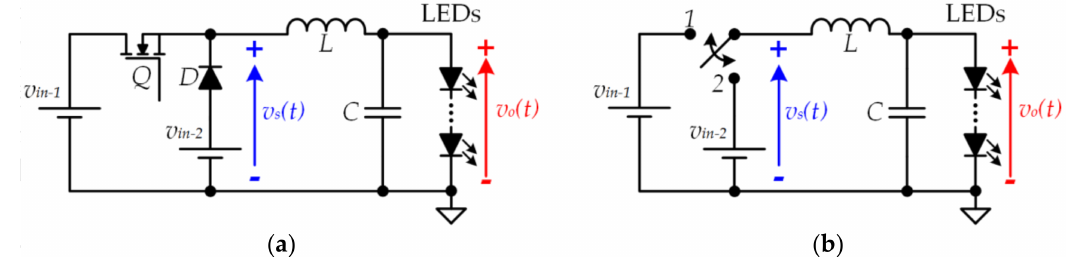
Figure 11. ( a ) Two-input buck converter; ( b ) Equivalent circuit considering the two possible operating